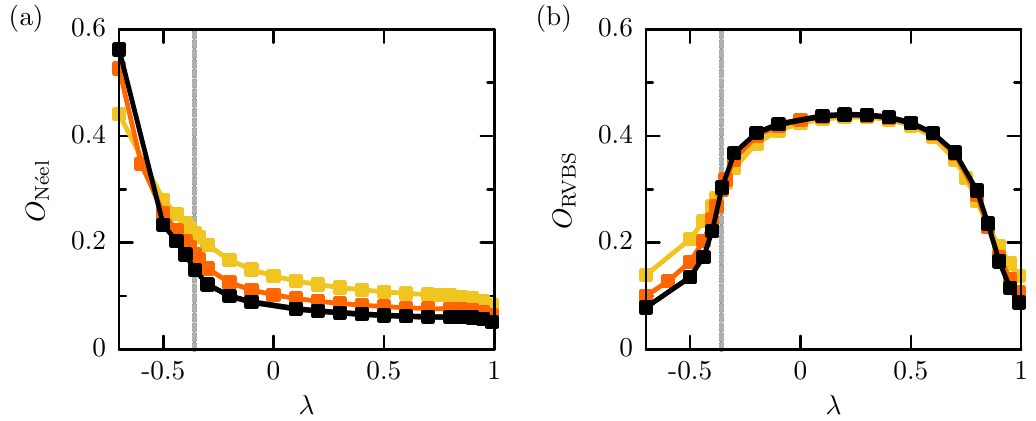
for the Néel phase and (b) O Néel